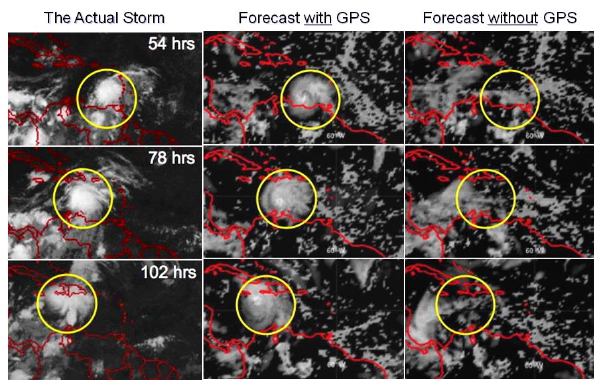
Fig. 23. Temperature ( ◦ C) and water vapor pressure (mb) (left) and corresponding bending angle and refractivity (right) profiles associated with a well-defined ABL. The bending angles reach a sharp maximum at the top of the ABL, which is character- ized by large vertical gradients of temperature and water vapor (Sokolovskiy et al.,